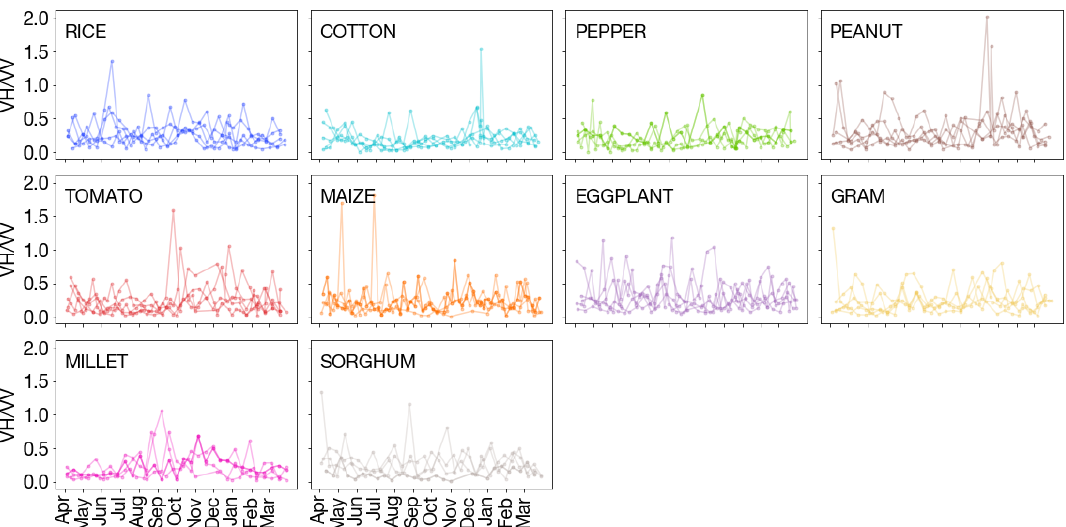
Figure A2. Sentinel-1 time series. For each crop type, VH/VV of Sentinel-1 time series at 5 randomly sampled submissions are shown from 1 April of the crop year to 31 March of the next year.